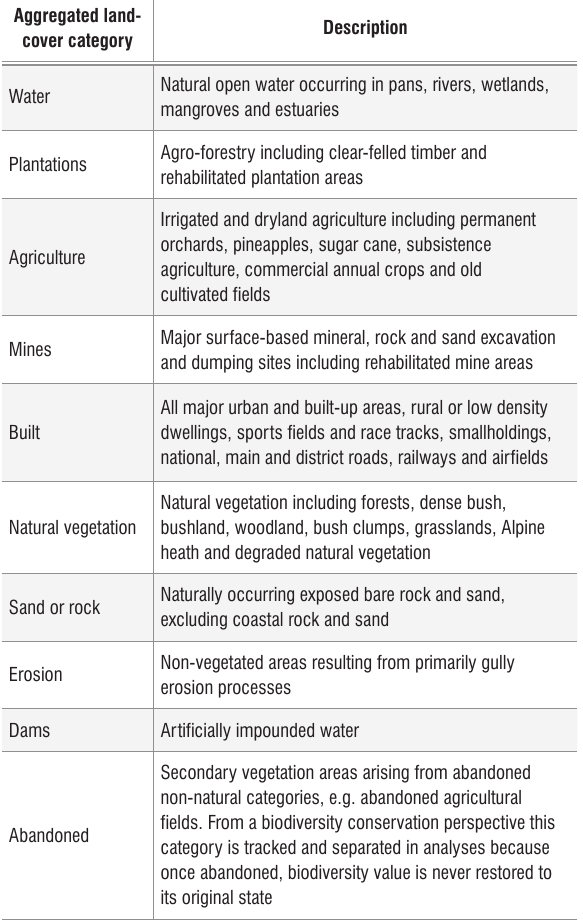
The aggregated land-cover categories and a description of the categories included in the aggregated class Aggregated land- cover